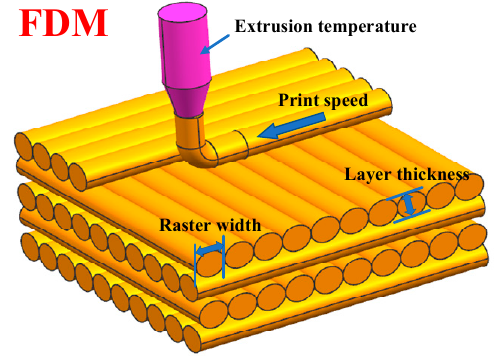
Figure 1. MIT-20 testing machine for mechanical strengths: ( a ) tensile; ( b ) compressive.